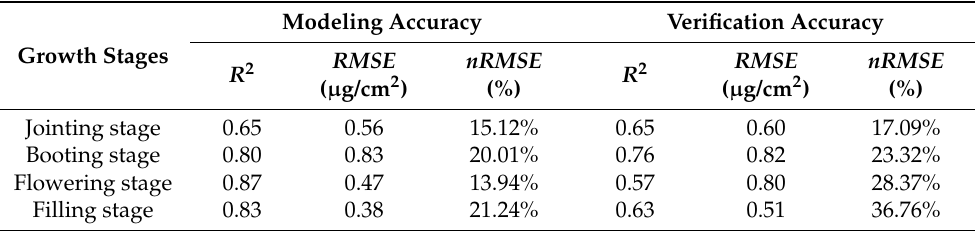
Table 2. Estimation of leaf area index based on fractional differentiation spectrum at different growth stages and modeling results of support vector